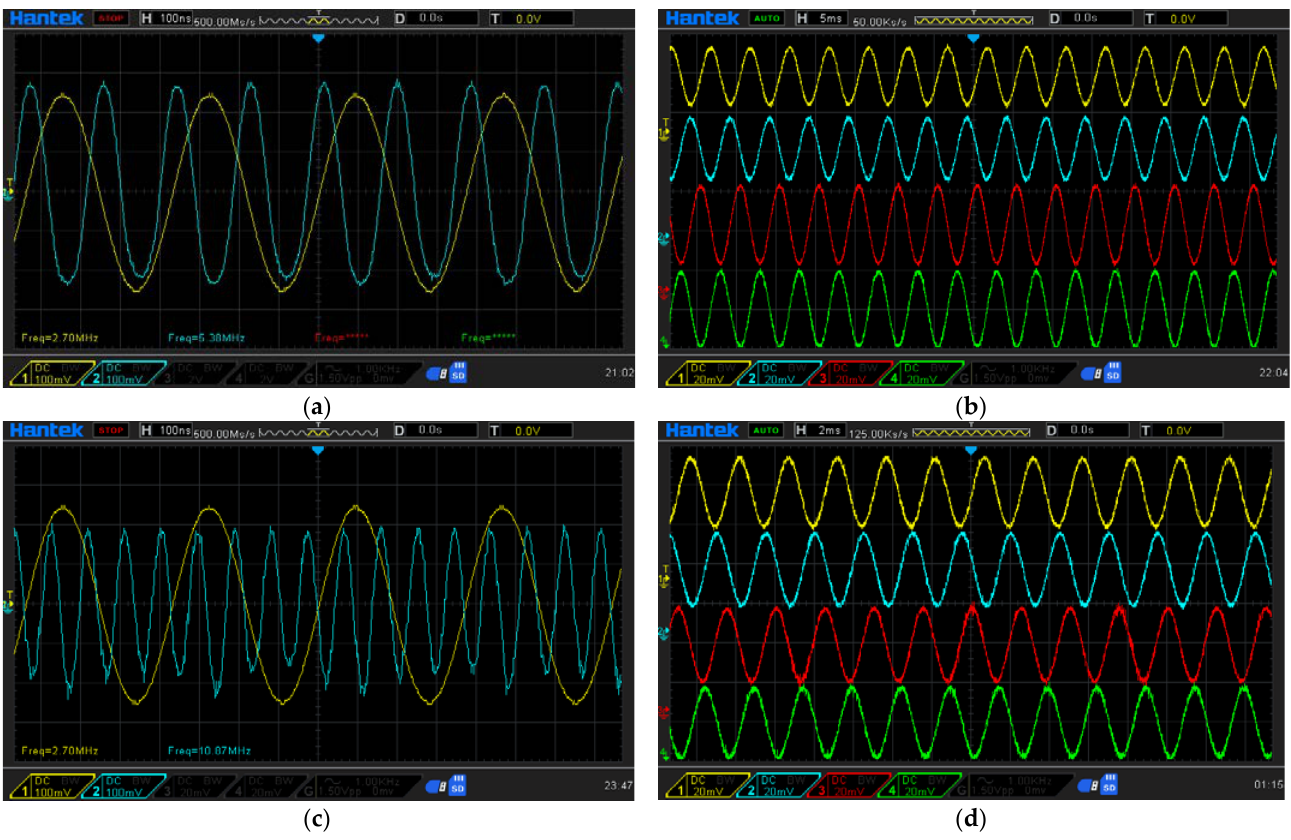
Figure 9. Results of the analog interpolator testing: ( a ) generated signal (blue) and its multiplication signal (yellow) in 1st-order multiplication; ( b ) output signal from the LIA in 1st-order multiplication, vs. in-phase signal (yellow), 90-degree phase-shifted signal (blue), 180-degree phase-shifted signal (red), and 270-degree phase-shifted signal (green); ( c ) generated signal (blue) and its multiplication signal (yellow) in 2nd-order multiplication; ( d ) output signal from the LIA in 2nd-order multiplication, vs. in-phase signal (yellow), 90-degree phase-shifted signal (blue), 180-degree phase-shifted signal (red), and 270-degree phase-shifted signal (green).